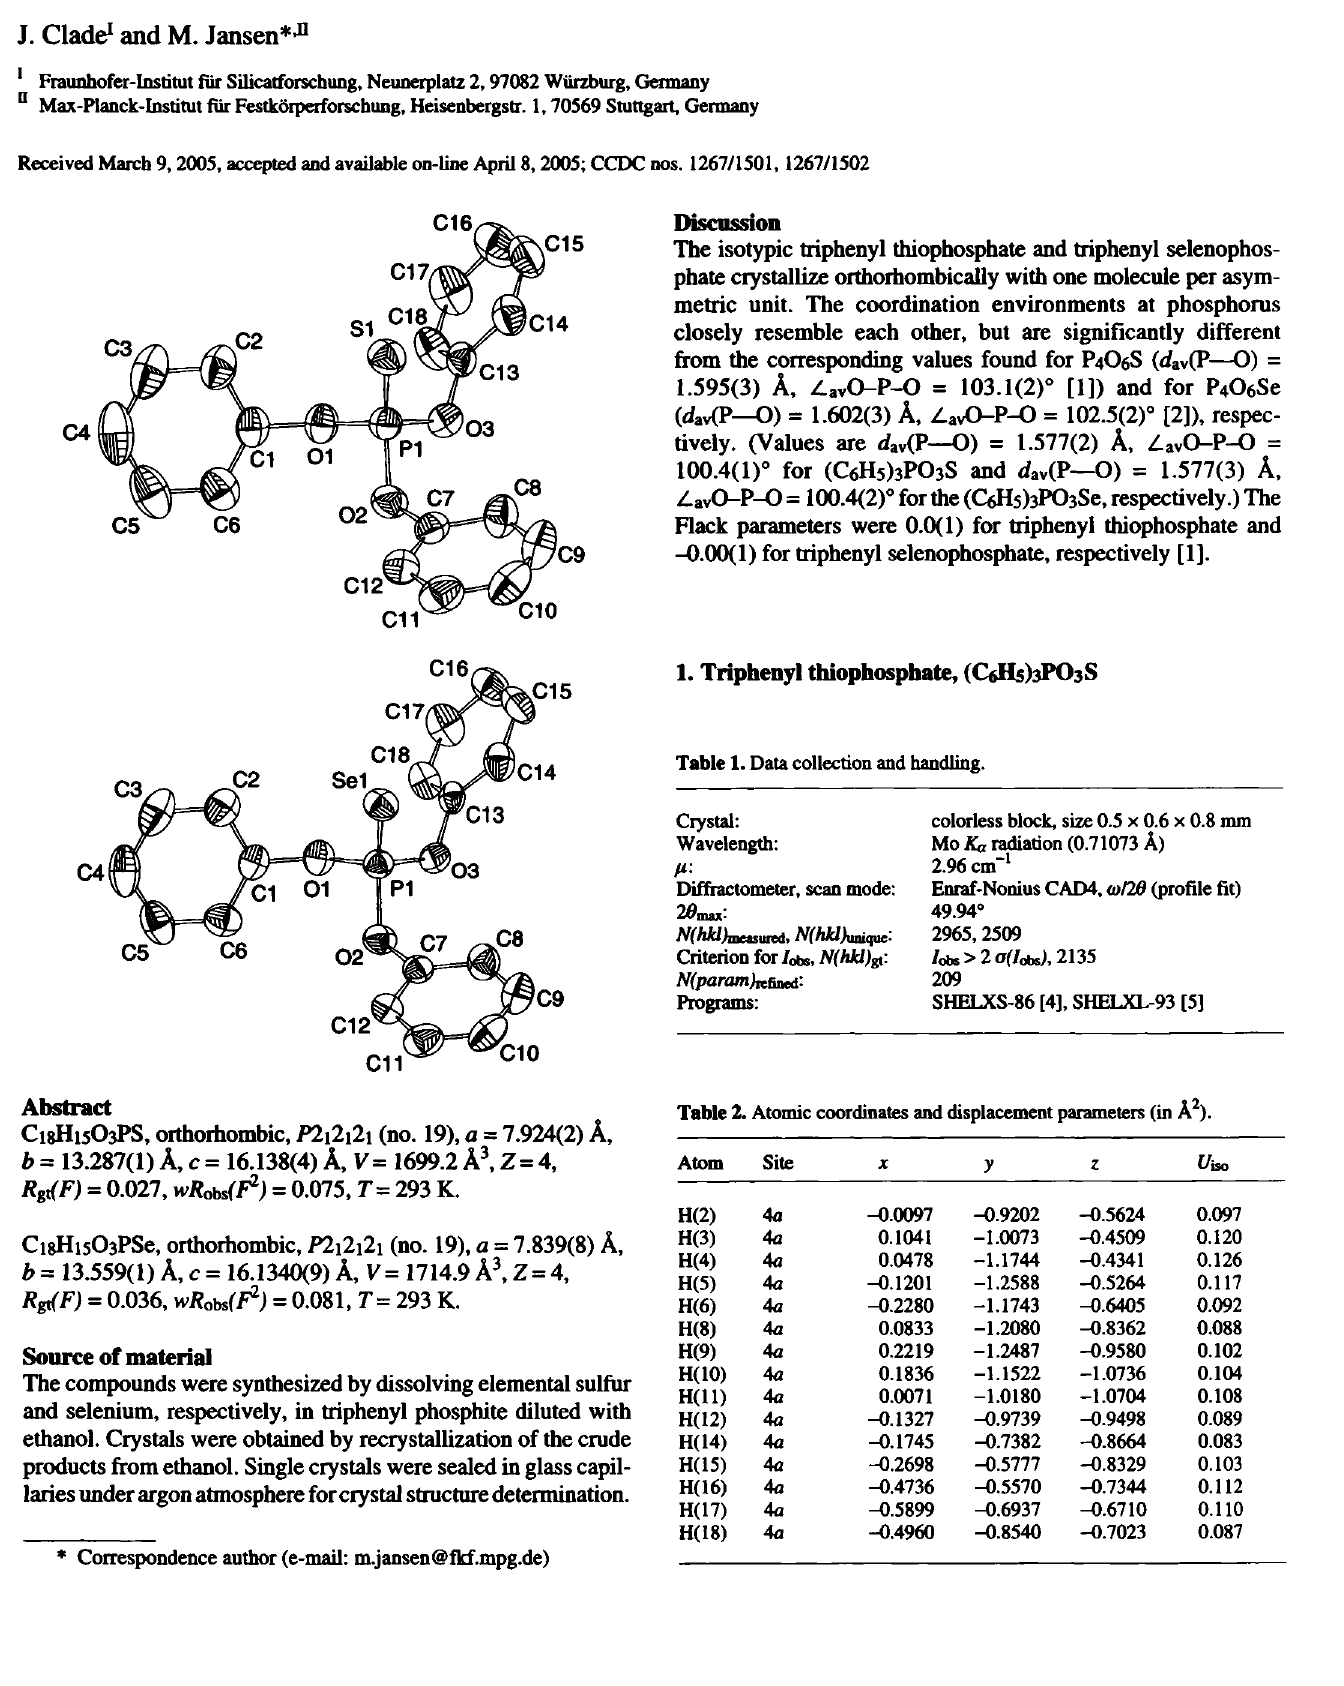
Table 2. Atomic coordinates and displacement parameters (in Ä 2